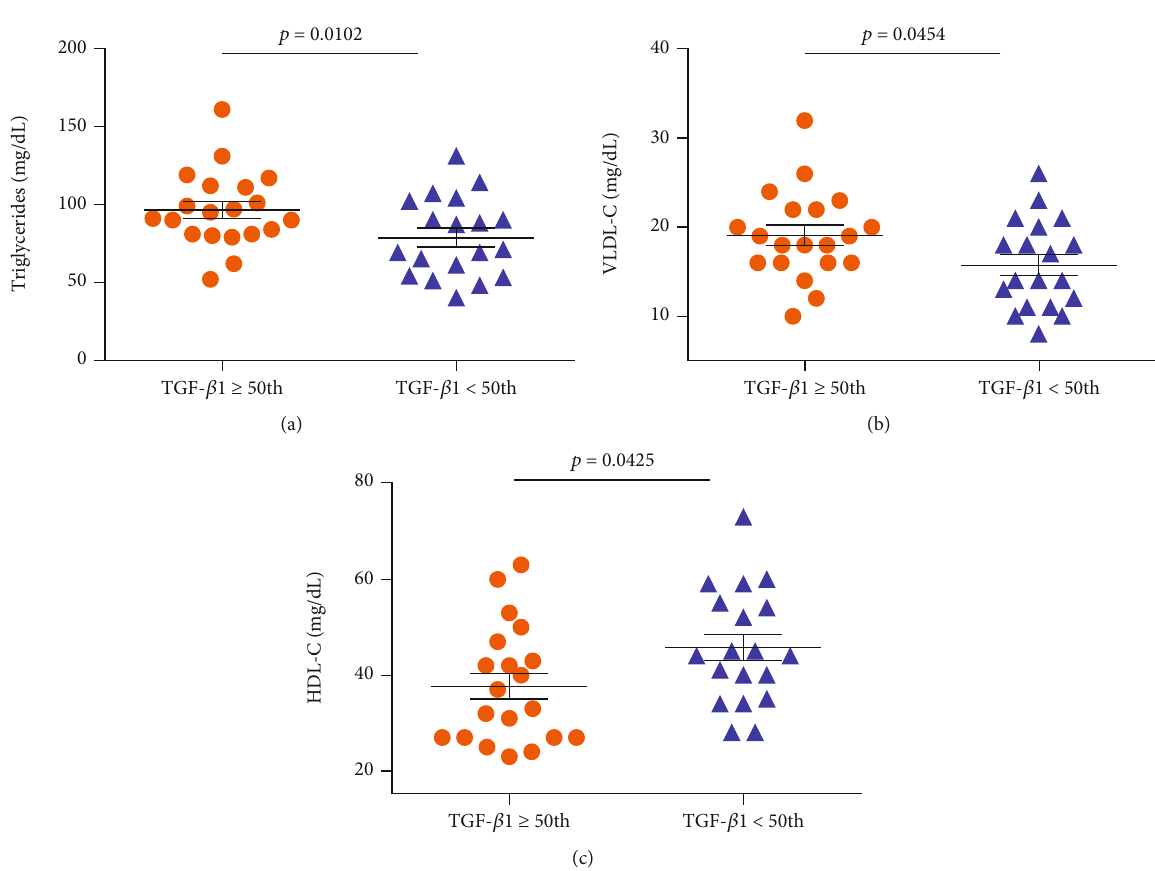
Figure 5: Associations between TGF- β 1 levels and lipid biomarkers in individuals with HbSC. Individuals with TGF- β 1 levels above the median ( TGF ‐ β 1 ≥ 47 : 80 ) exhibited (a) increased triglycerides, (b) increased VLDL-C, and decreased (c) HDL-C levels (all p values were obtained by the independent t